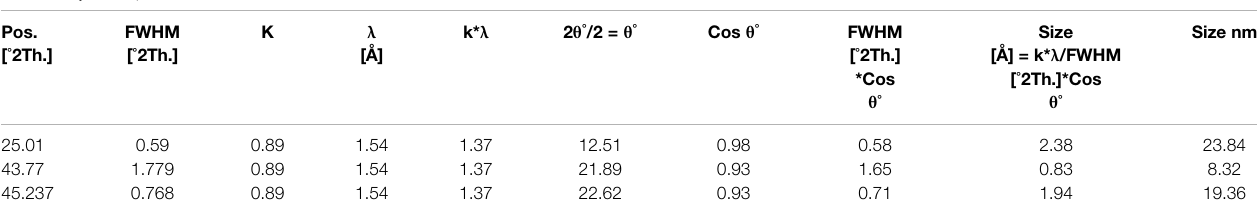
TABLE 1 | XRD spectral data for mustard